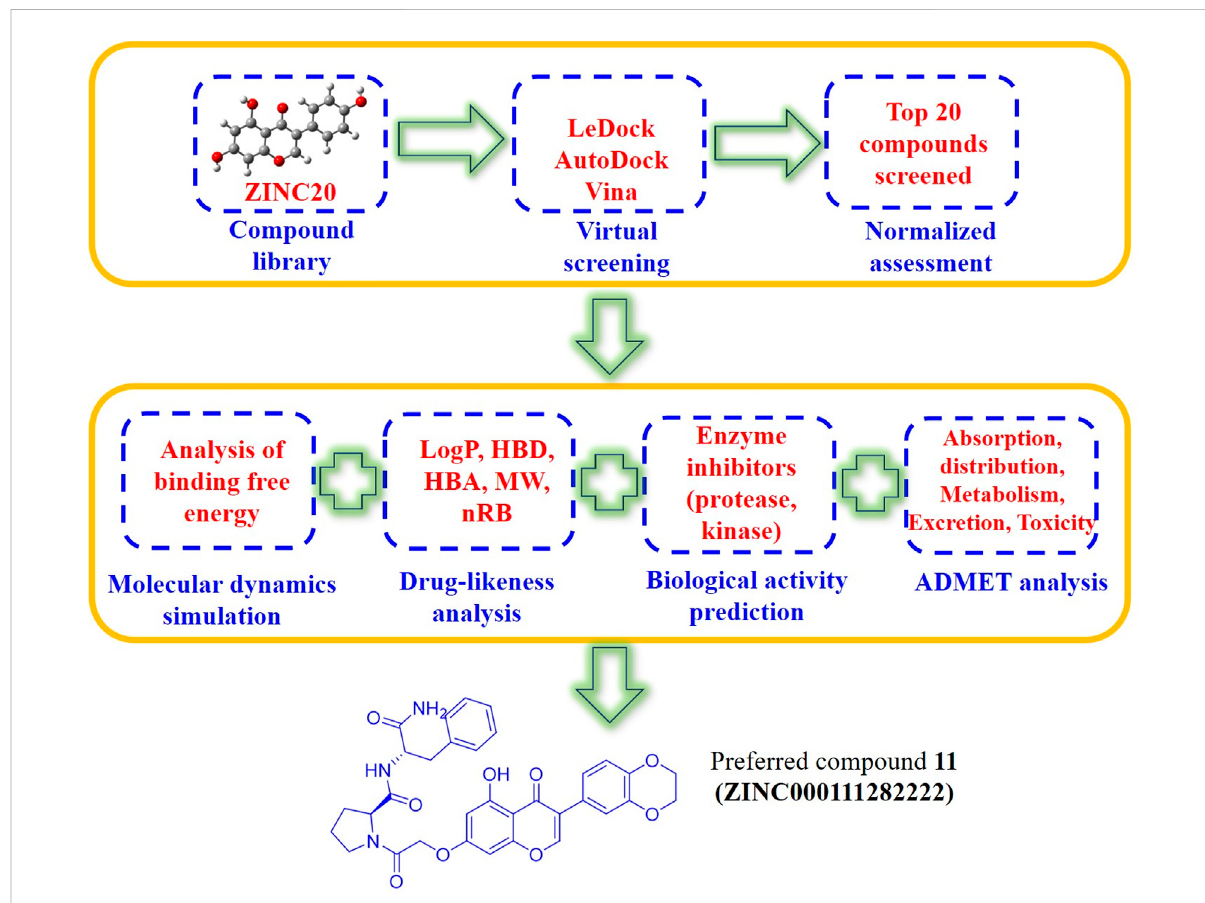
FIGURE 2 Schematic diagram of the discovery of genistein-based anti-SARS-CoV-2 drug molecules.